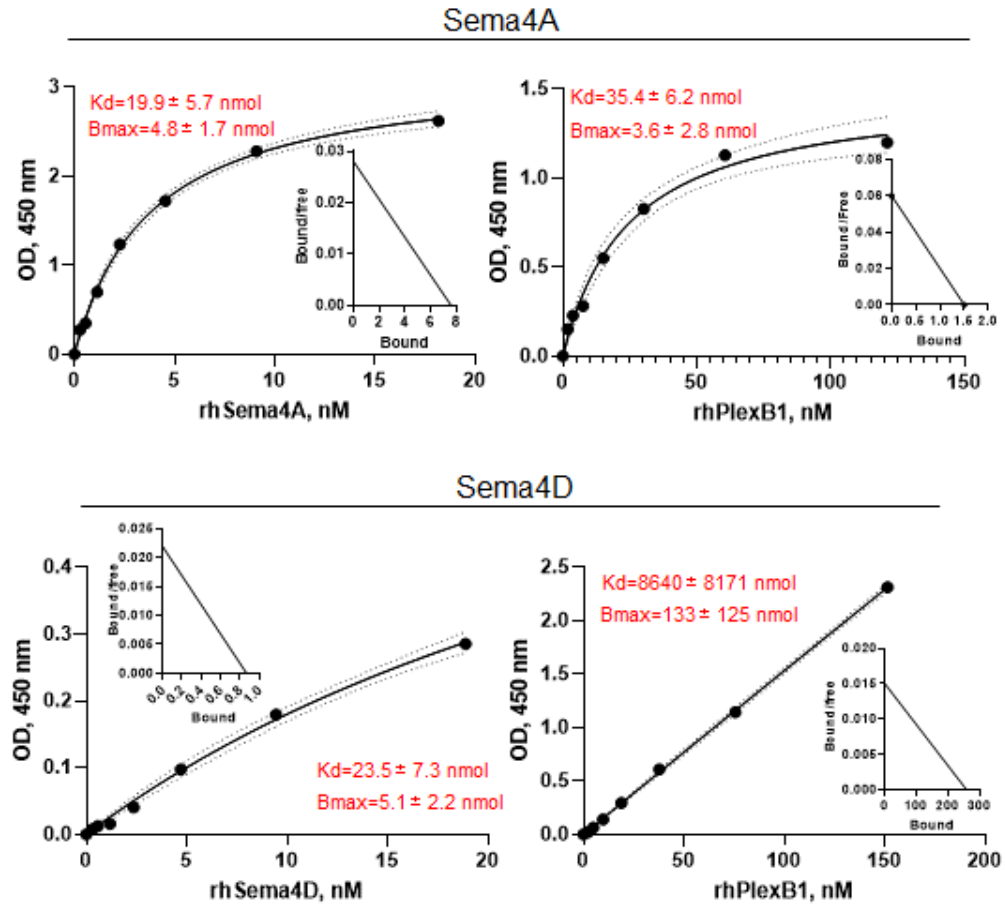
Figure 2. Sema4A binds Plexin B1 with higher affinity than Sema4D. Analysis of Sema4A-Plexin B1 and Sema4D–Plexin B1 interaction by the direct ligand–receptor binding ELISAs with respective Scatchard plots shown as inserts. Either Plexin B1 (8 – 10 μg/mL ) or Sema4 (2 μg/mL ) were immobilized on the Immulon 2 plates overnight and corresponding ligands or receptor were added in duplicates in varying doses, starting from 2 μg/mL for Sema4 and 10 μg/mL for Plexin B1. The amount of bound ligand was measured spectrophotometrically based on the HRP-labeled Abs to corresponding protein tags (Fc, GST, or His). Calculations of the equilibrium dissociation constants were performed utilizing GraphPrizm 8.0. software. For the KD value determination, the data was fitted to the ‘One site-specific binding with Hill slope’. Data are shown in mean ± SEM from three independent ELISA experiments. The curves demonstrate a direct 1:1 ligand–receptor binding and are representative of three independent assays.